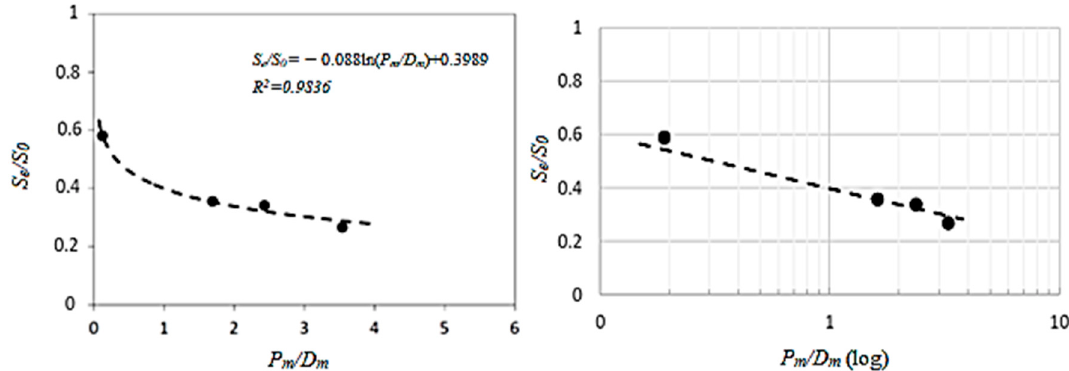
Figure 9. Fatigue S e / S o ratio vs. ( P / D ) m ratio for R , C1, C2, and C3